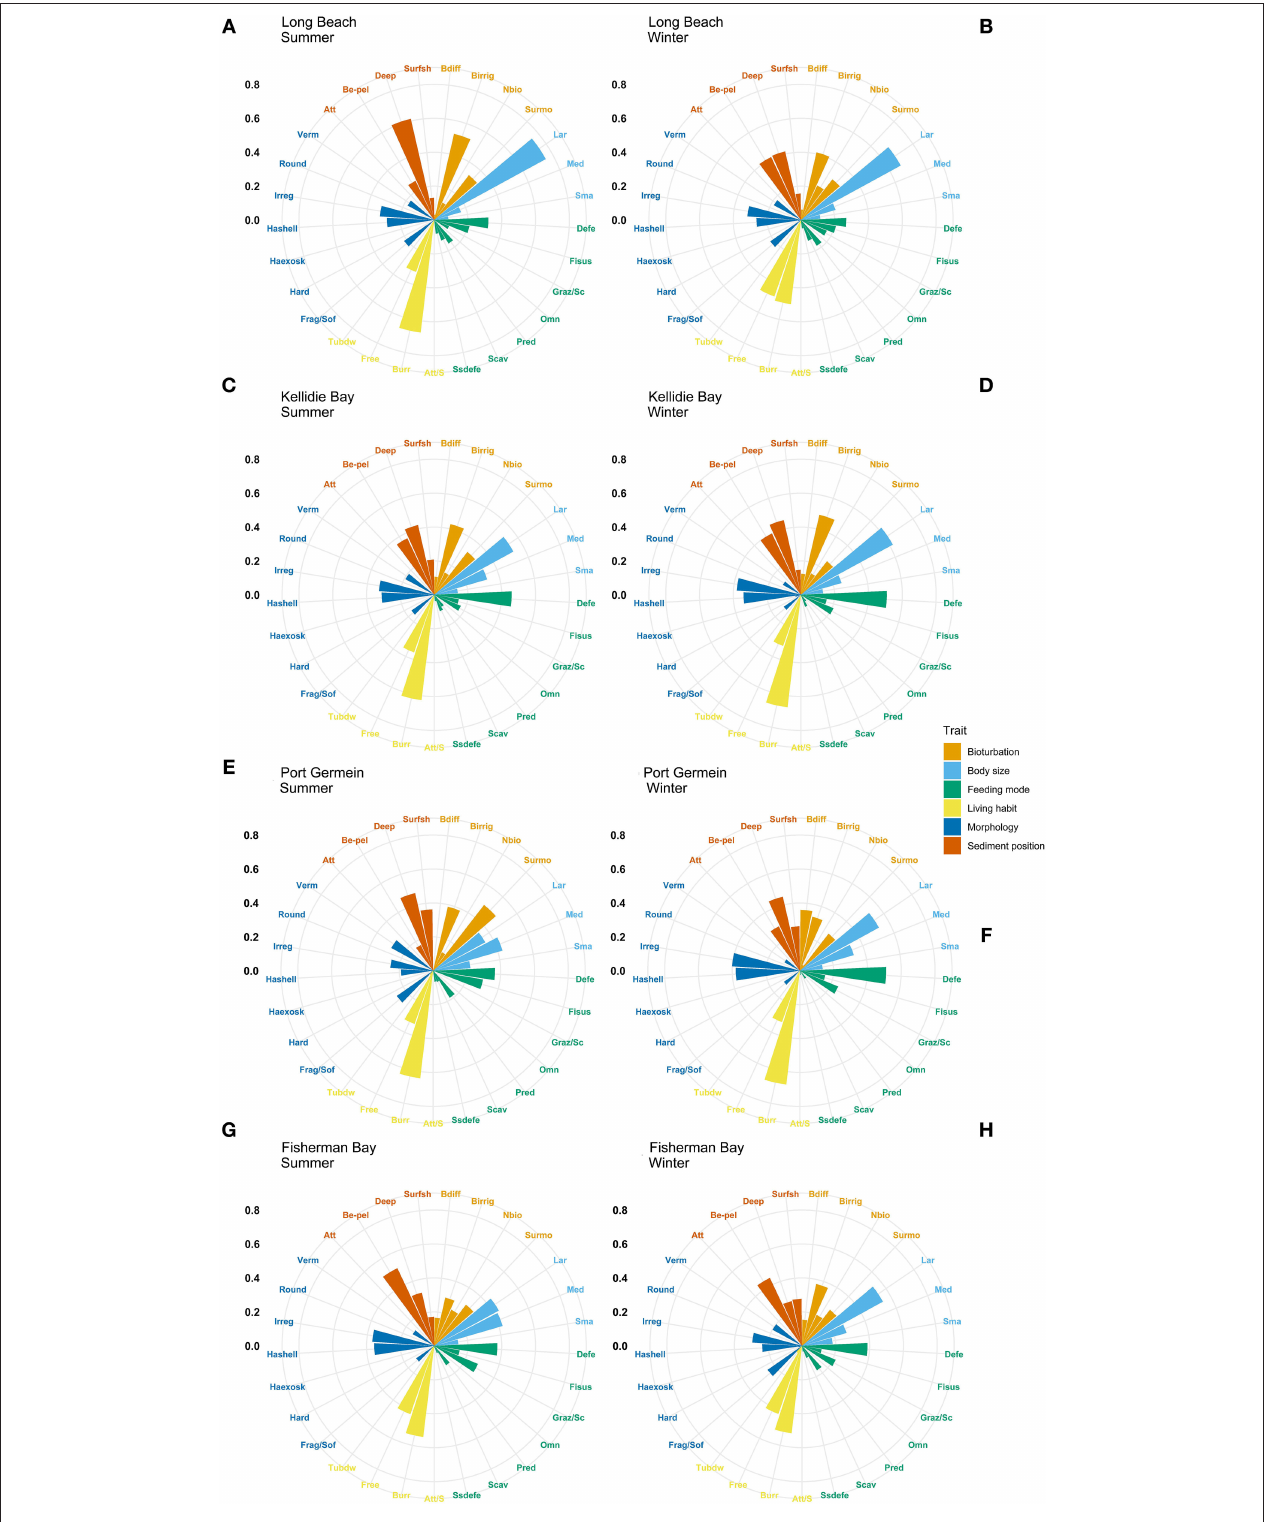
FIGURE 4 | Community-weighted means (CWM) of trait-modalities expression. Scale represents the percentage contribution to CWM. Trait modalities labels (acronyms) are defined in Table 2 . Long Beach (A) summer, (B) winter; Kellidie Bay (C) summer, (D) winter; Port Germein (E) summer, (F) winter; Fhiserman Bay (G) summer, (H)